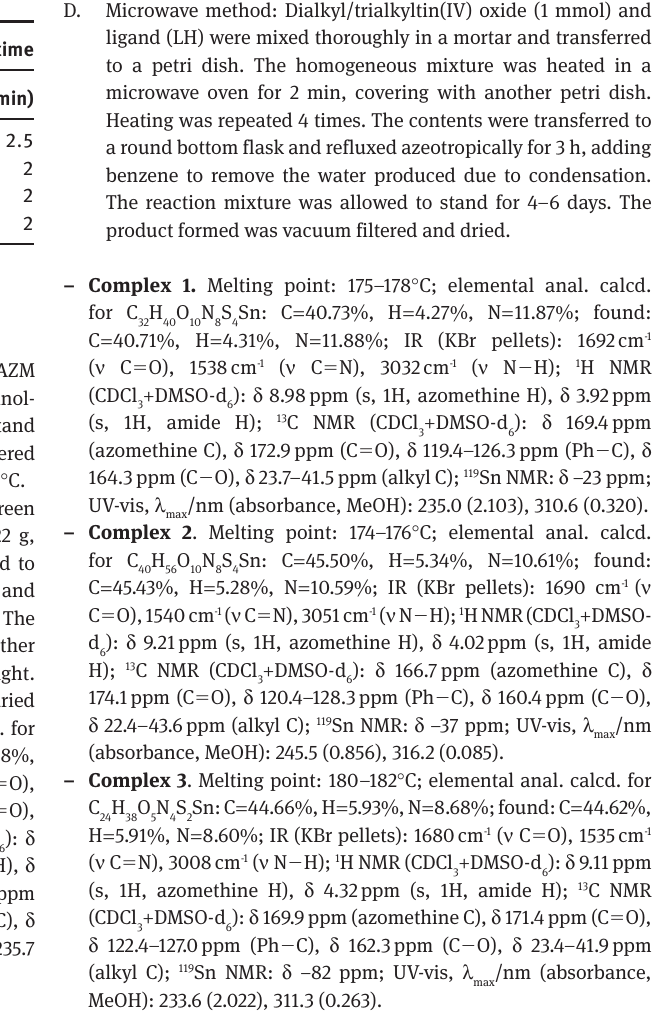
Table 1 Comparison of reaction time and yield for two different methods of